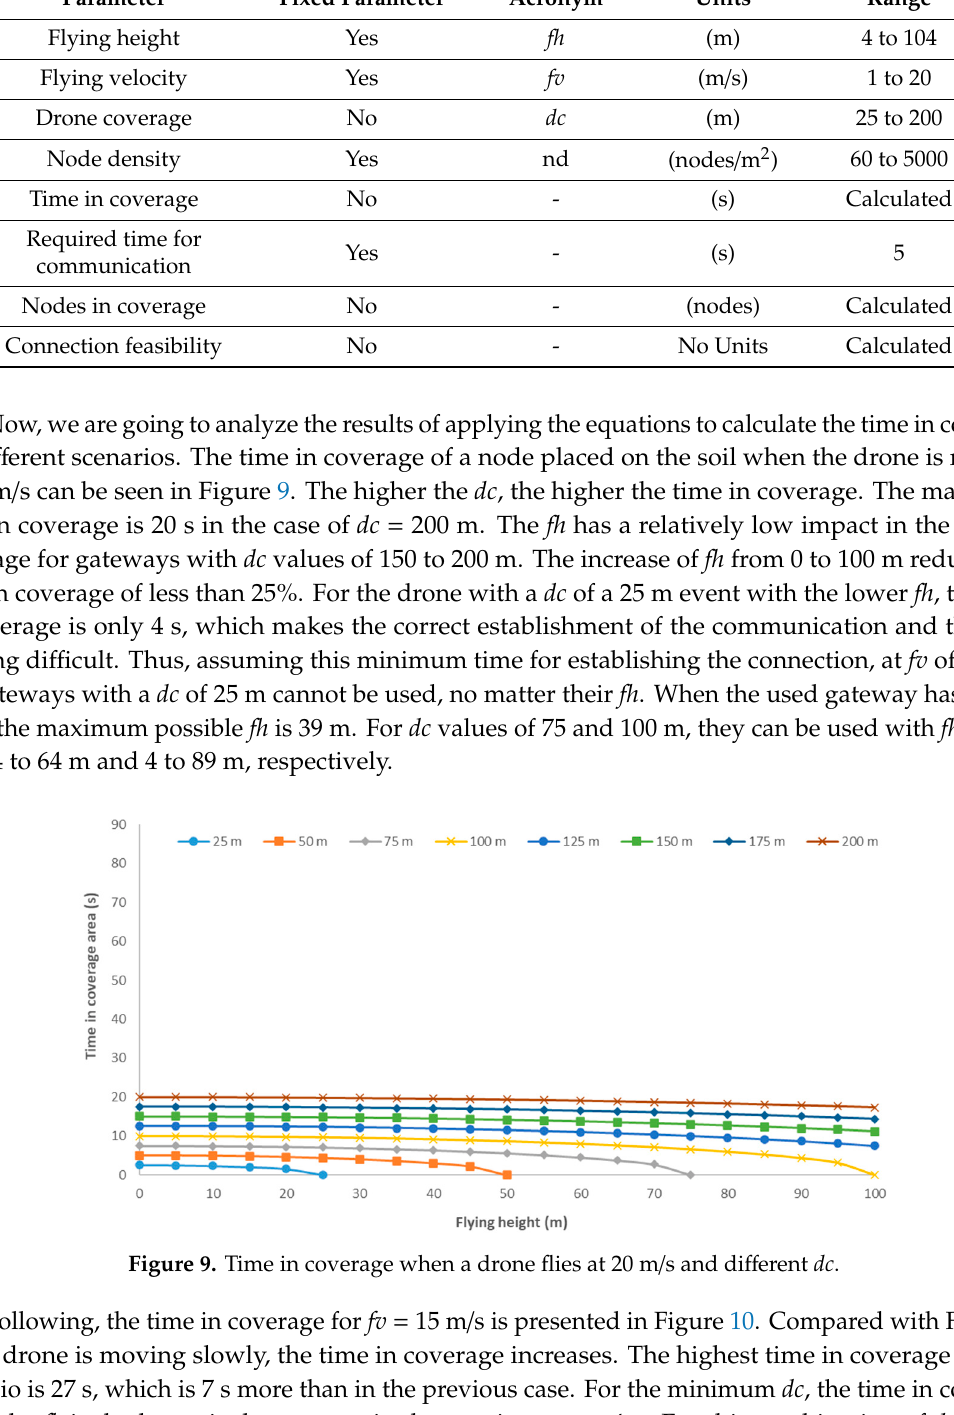
Figure 9. Time in coverage when a drone flies at 20 m/s and different dc .